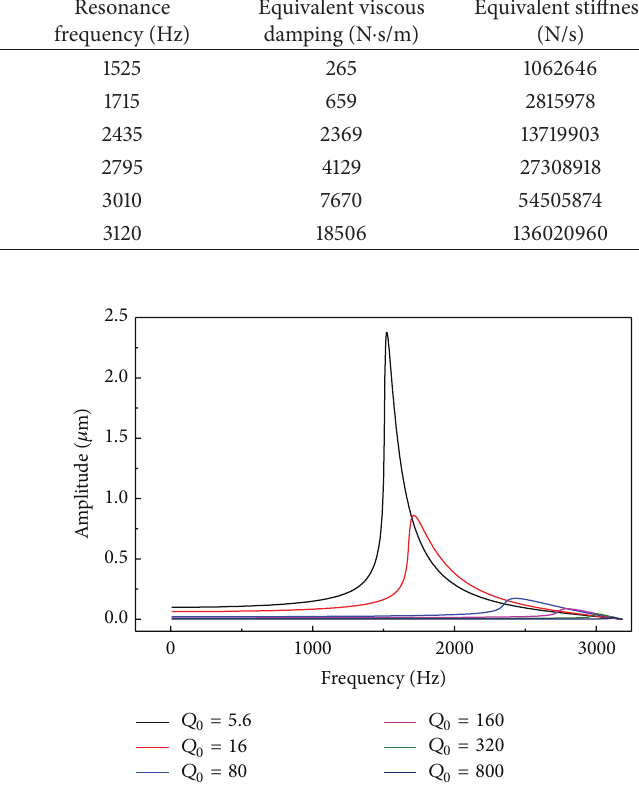
Figure 7: Vibration response of dry friction blade 𝑚 1 with shroud structure.